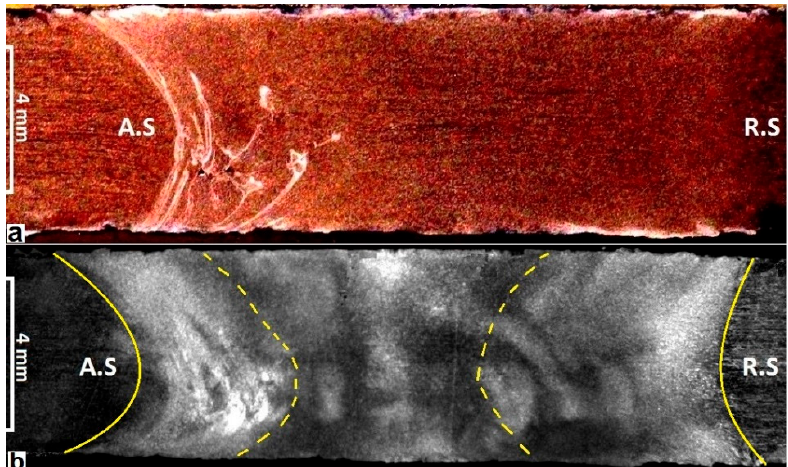
Figure 3. Macrostructure of the cross-section of the BFSW joint for two different etchants, ( a ) etchant A, and ( b ) etchant B. The pictures belong to the same sample and the same location of the cross section, after re-polishing and re-etching the surface. The solid yellow lines demarcate the base material, and the dashed lines denote the approximate location of the zone directly affected by the pin and shoulder.